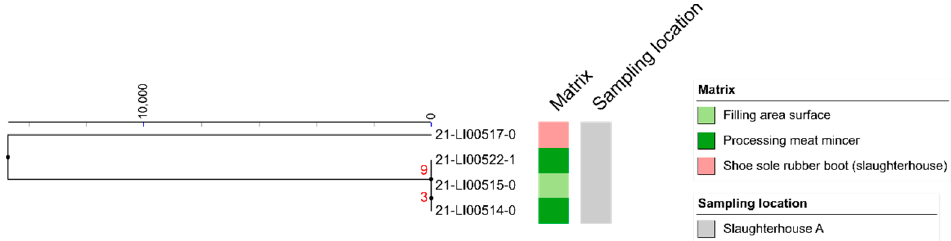
Figure 3. Clustering of 4 L. welshimeri isolates found in the slaughterhouse environment in a linkage tree with differences of less than 1,000 SNPs indicated.